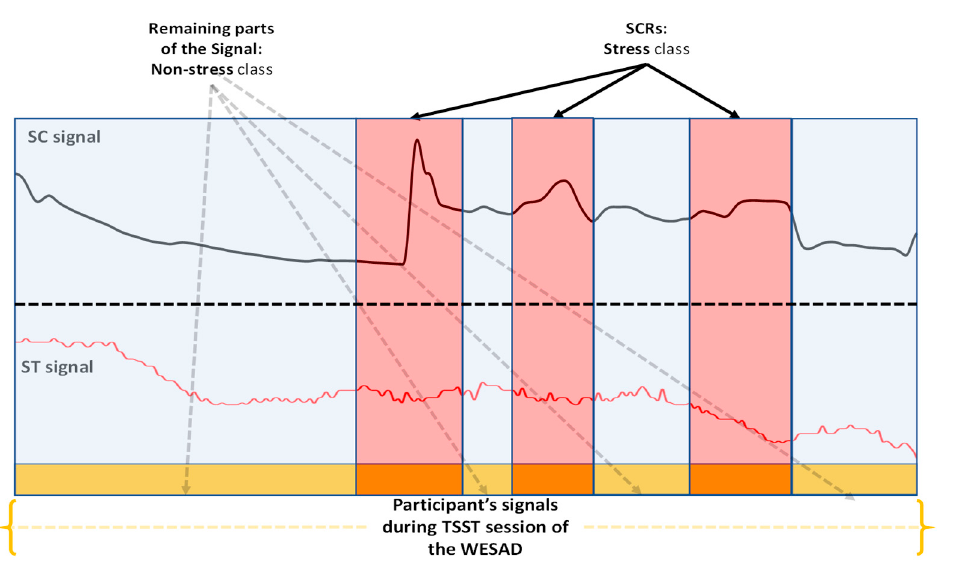
Figure 2. An example of the dataset creation process. From each skin conductance (SC) and skin temperature (ST) signal in the WESAD dataset we extract the appropriate parts as indicated by the duration of the detected NS-SCRs. The detected NS-SCRs segments served as the stress class. The rest parts of the signal served as the nonstress class.